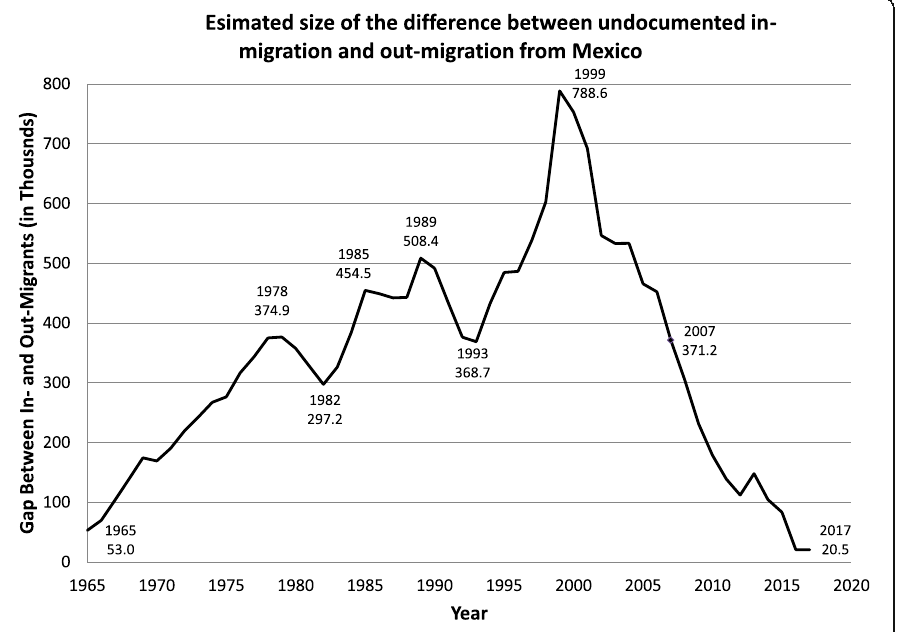
Fig. 10 Estimated size of the difference between undocumented inmigration and out-migration from